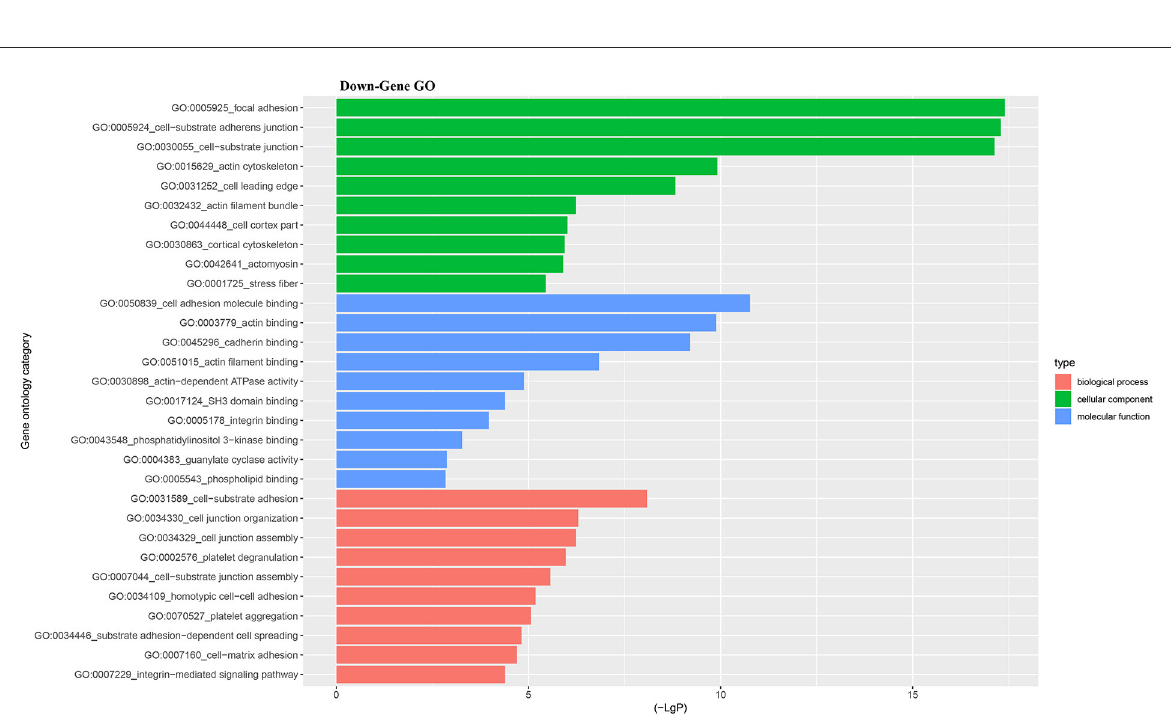
FIGURE4 Top 10 down-regulated GO terms of differentially expressed mRNAs which covering biological process, cellular component and molecular function,